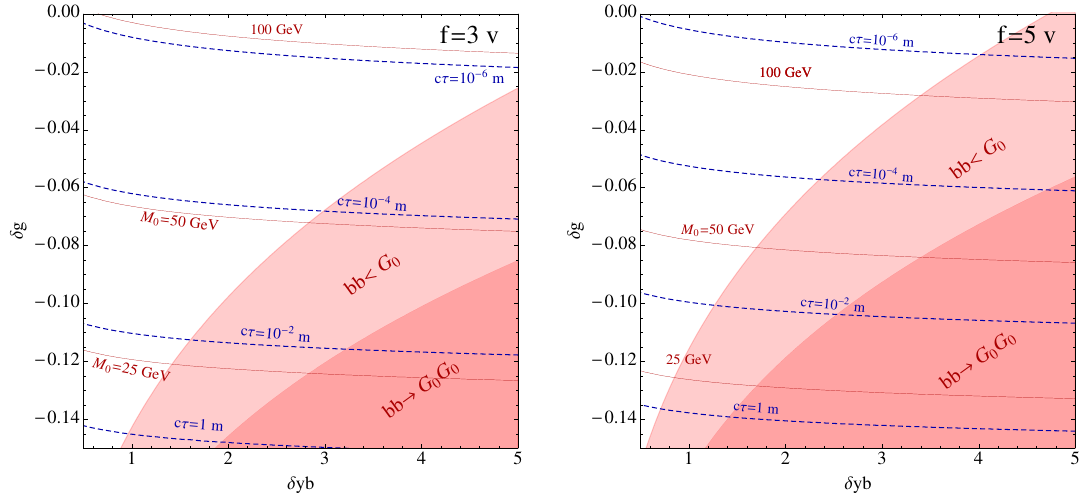
Figure 10 . Summary of the structure of the dark sector in the Fraternal Twin Higgs. The light pink shaded region shows where the 0 ++ glueball, i.e. G 0 , is the LDP, darker shading indicates where the decay of bottomonia into glueballs pairs is allowed. Red contours indicate the mass of the LDP. Blue dashed contours denote the average c(cid:28) of G 0 . Left: we (cid:12)x the Twin Higgs VEV to f = 3 v . Right: we (cid:12)x the Twin Higgs VEV to f = 5 v . For the spectrum of the stable bottomonia, we take ref. [86]